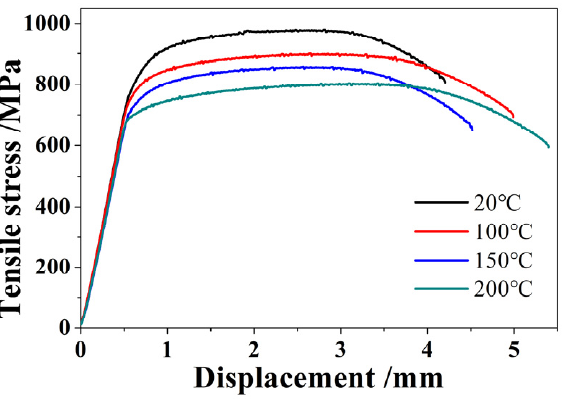
Figure 3. Engineering stress–displacement curve of Al-Zr-Mo-Cr titanium alloy.